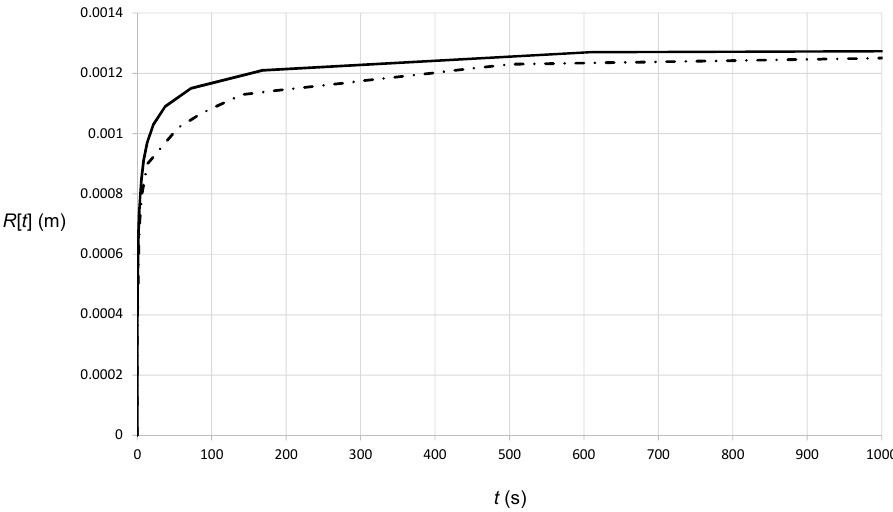
Figure 4. Heat transfer with phase change in a semi-infinite powder bed with continuous heat release at a single point. The curves show the melt pool radius (semi-spherical interface) where the temperature has the constant value T melt . The solid curve is the analytical solution obtained assuming a single material, i.e., homogeneous powder (Equation (12)), and the dashed curve is the numerical solution. In the latter, we assume that there are two phases: solid and liquid.